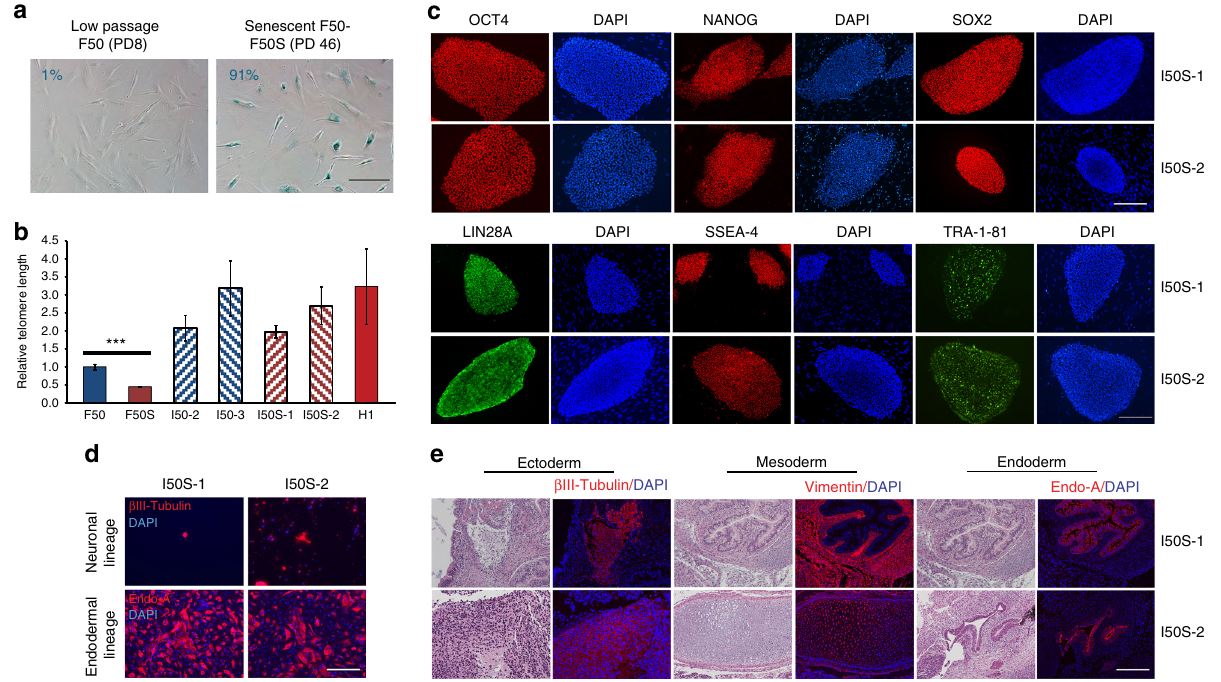
Fig. 5 Successful reprogramming of senescent human fi broblasts. a Adult human primary fi broblasts from a 50-year-old patient (F50) were passaged until they reached 46 population doublings (PDs), at which point the cells stopped dividing, and started exhibiting a senescent phenotype with an enlarged cellular morphology and 91% positivity for senescence-associated β -galactosidase (F50S). Scale bar, 200 µ m. b Elongation of telomeres in iPSCs generated from F50 and F50S. The length of telomeres in the indicated cell lines was measured by qPCR analysis. Error bars, mean ± s.d. ( n = 3). Prolonged fi broblast passaging of F50 resulted in a signi fi cant shortening of telomeres in F50S (*** P < 0.001). P values were calculated using the unpaired two-tailed Student ’ s t test. c Immuno fl uorescent analysis showing expression of a panel of pluripotency markers in iPSC lines derived from F50S (I50S-1 and I50S-2). See Fig. 6b and Supplementary Figs. 11 and 12 for controls and iPSC lines derived from F50. Scale bar, 250 µ m. d Immunostaining showing expression of the neuronal marker β III-Tubulin (TUJ1) (ectoderm), and the endoderm-speci fi c cytokeratin Endo-A in iPSCs derived from F50S subjected to directed differentiation. See Fig. 6d for directed differentiation of iPSC lines derived from F50. Scale bar, 250 µ m. e Hematoxylin and eosin staining and immuno fl uorescent analysis of consecutive sections of teratomas derived from I50S-1 and I50S-2 showing histology and marker expression speci fi c to ectoderm ( β III-Tubulin (TUJ1), neural tissues), mesoderm (vimentin, connective tissues), and endoderm (Endo-A, endothelium). See Fig. 6e for iPSC lines derived from